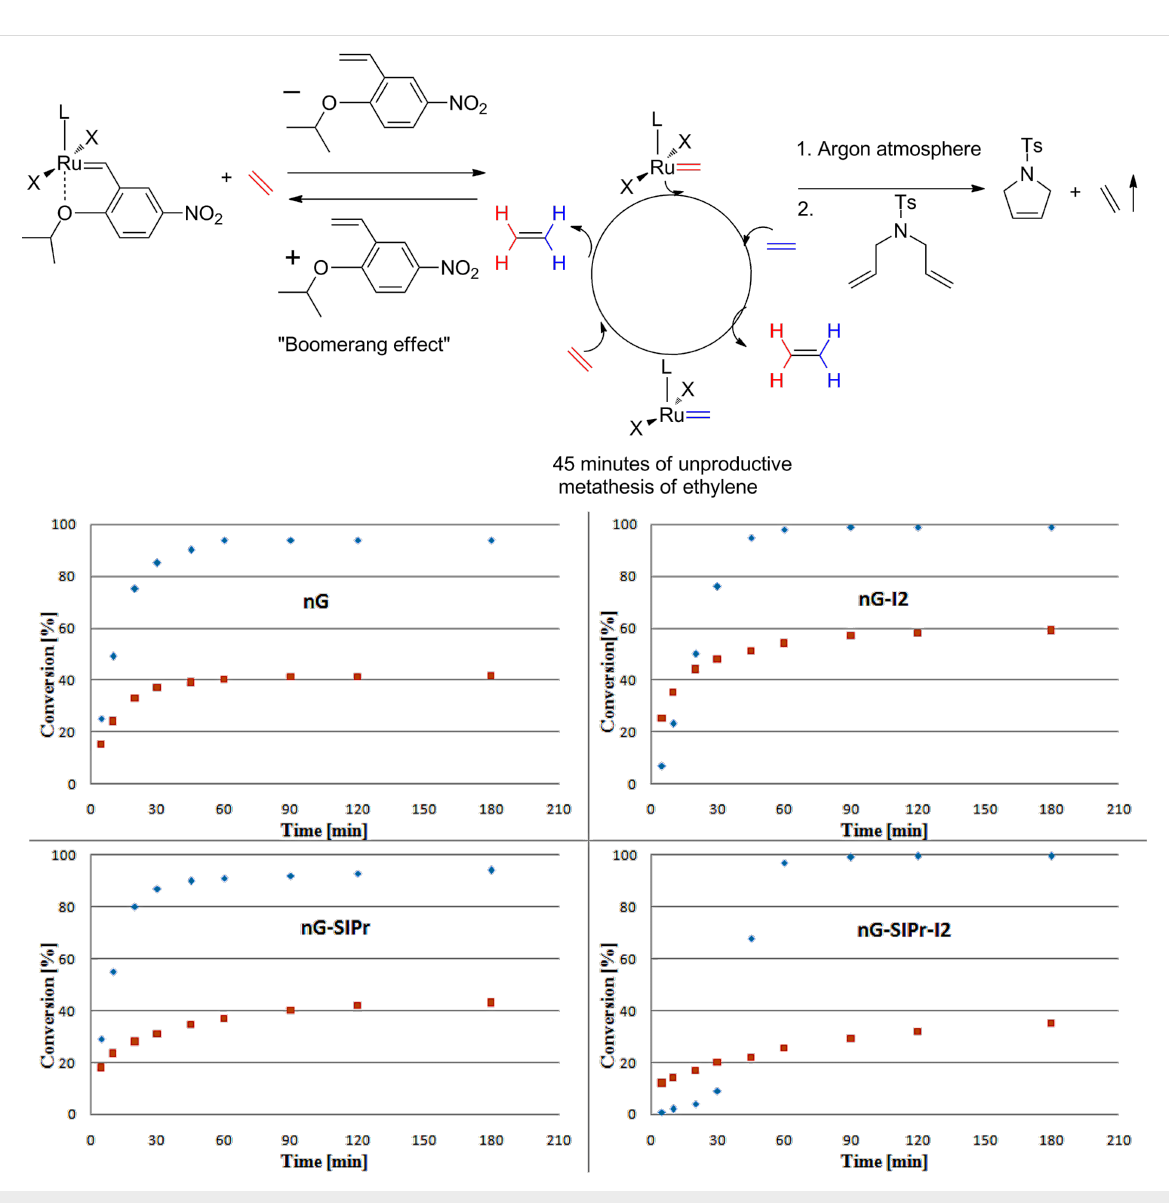
methylidenes generated from nG-I2 proved to be of great importance when macrocyclizations were run without active removal of ethylene (no flow of argon over the reaction mix- ture). In these conditions, which simulate the difficult removal of ethylene on large scale processes, nG-I2 delivered expected products with fair yields (77% and 57% of 19 and 20 , respect- ively) while other catalysts demonstrated less than a 10%